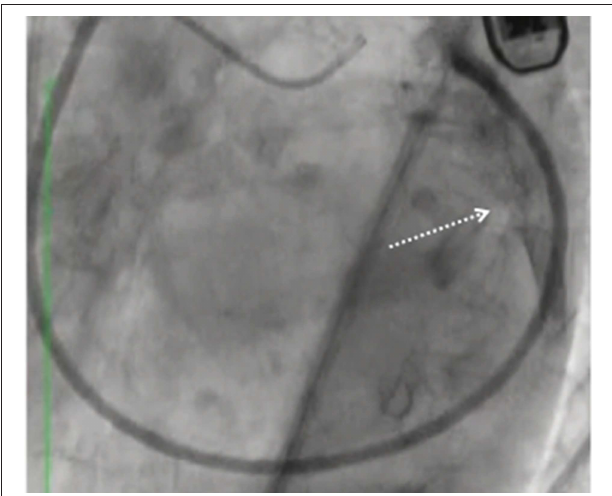
FIGURE 3 | Pericardial effusion (arrow) and cardiac tamponade following the Carillon device delivery system advancement outside the coronary sinus.